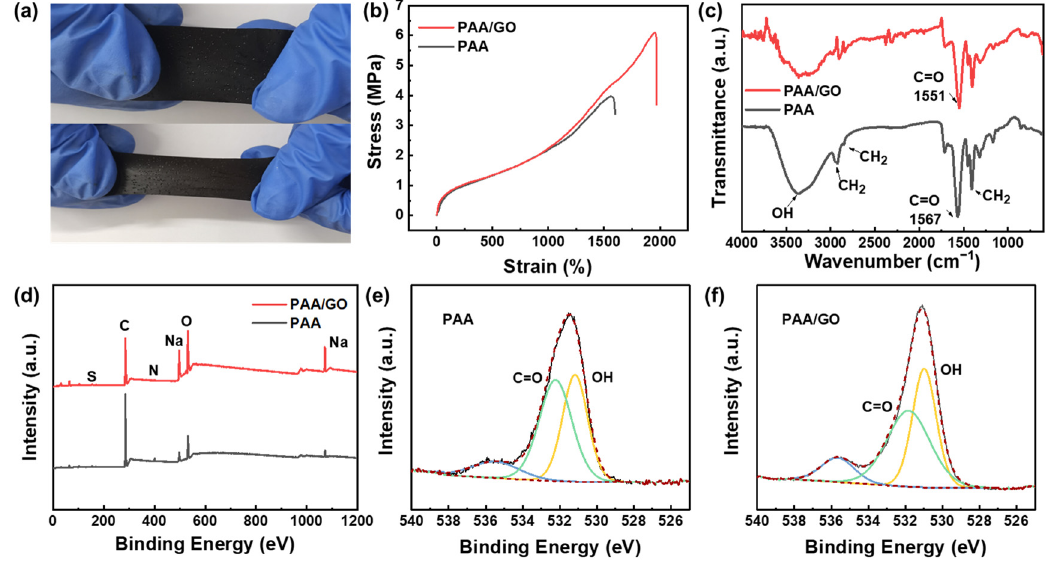
Figure 3. ( a ) Tensile performance of PAA/0.5%GO composite gel electrolyte. ( b ) Tensile stress-strain curve comparison of the PAA and PAA/0.5%GO composite gel electrolyte. ( c ) FTIR and ( d ) XPS full spectrum of PAA and PAA/0.5%GO. O1s peak fitting of ( e ) PAA and ( f )